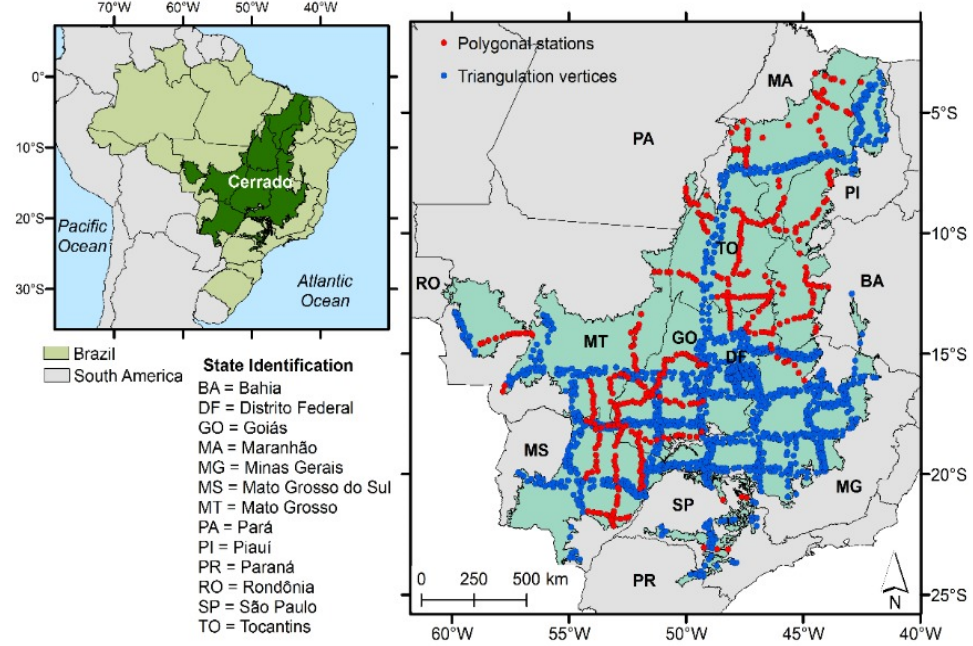
Figure 1. Location of the study area (Cerrado biome) in Brazil and the 1695 reference stations (Brazilian Institute of Geography and Statistics’ (IBGE’s) polygonal stations and triangulation vertices).